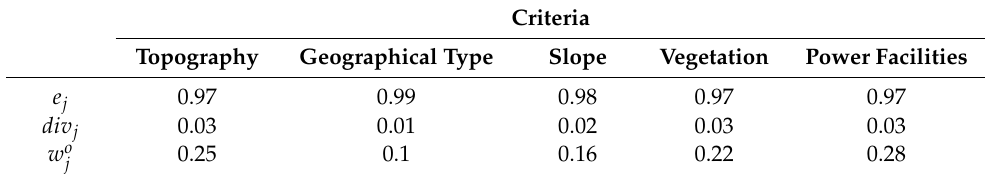
Table 12. The objective